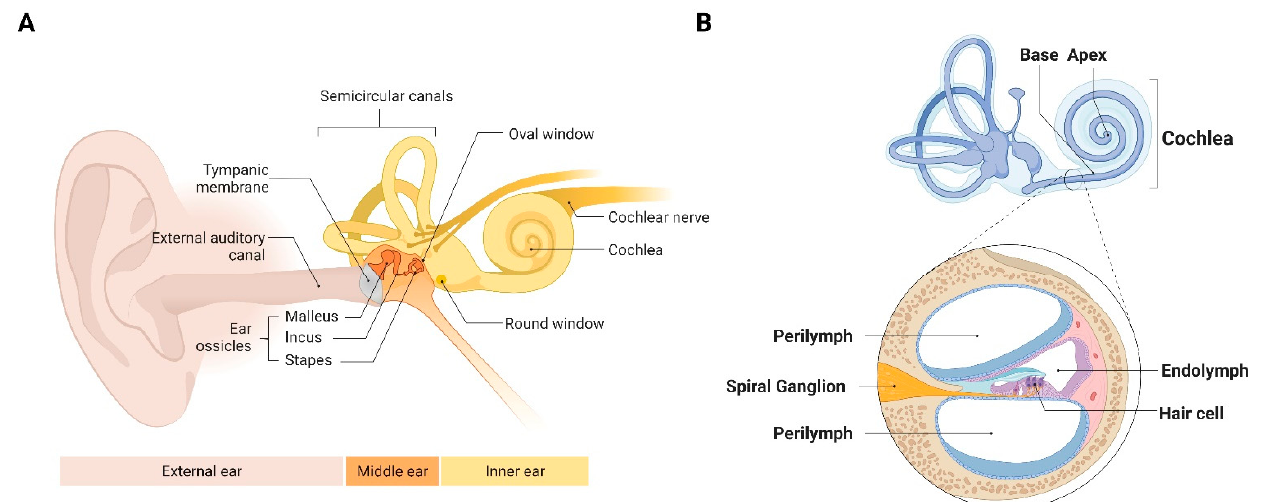
Figure 2. Anatomy of the ear and auditory system. ( A ). Outer, middle, and inner ear shown with labelled anatomic structures that are important for hearing. ( B ). Illustration of a human cochlea with the cochlear base and apex labelled. Hair cells at the cochlear base interpret high-pitch sounds and hair cells at the apex interpret low-pitch sounds. The cross section of the cochlea shows the location of perilymph and endolymph. Hair cells resonate with incoming sound waves and send impulses to the brain via the spiral ganglion.